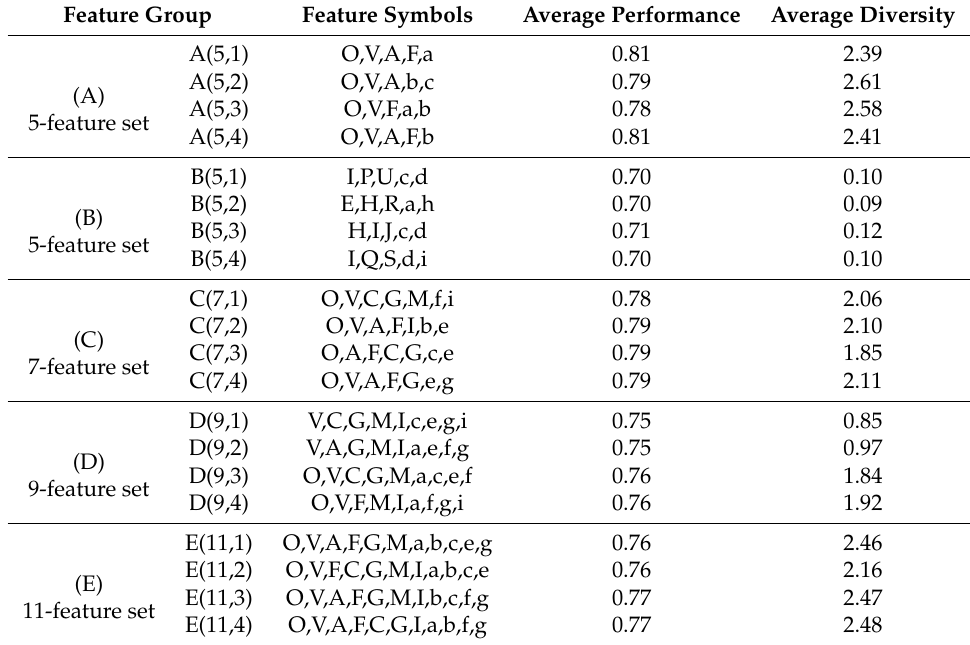
Table 4. Feature selection results.